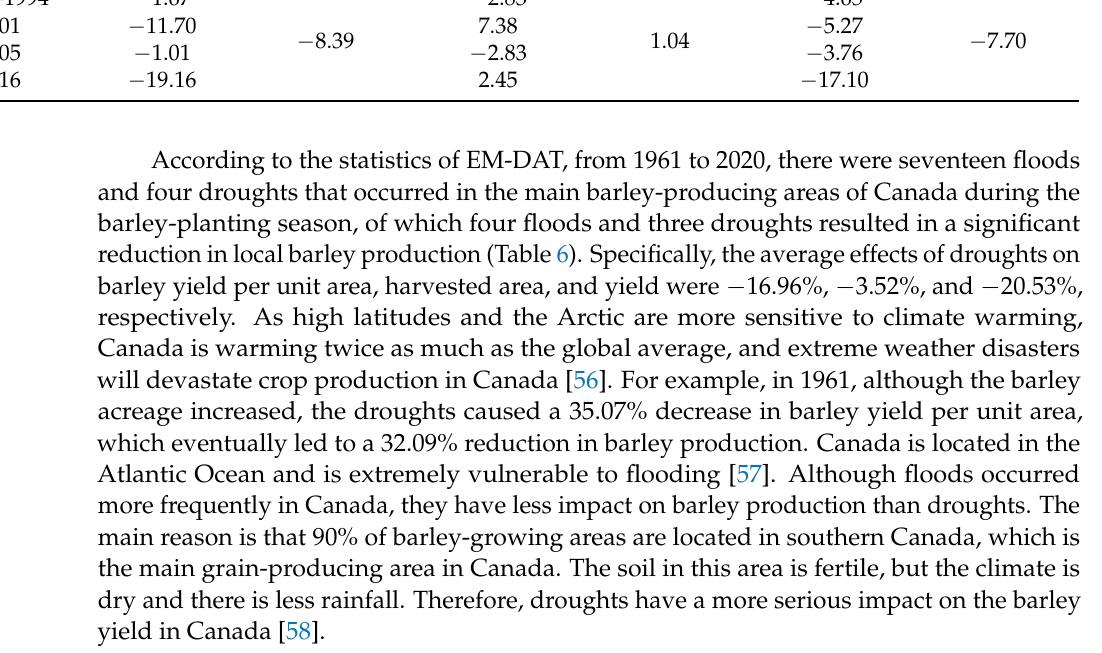
Table 6. Effects of droughts and floods on yield per unit area, area, and yield of barley in Canada (unit: